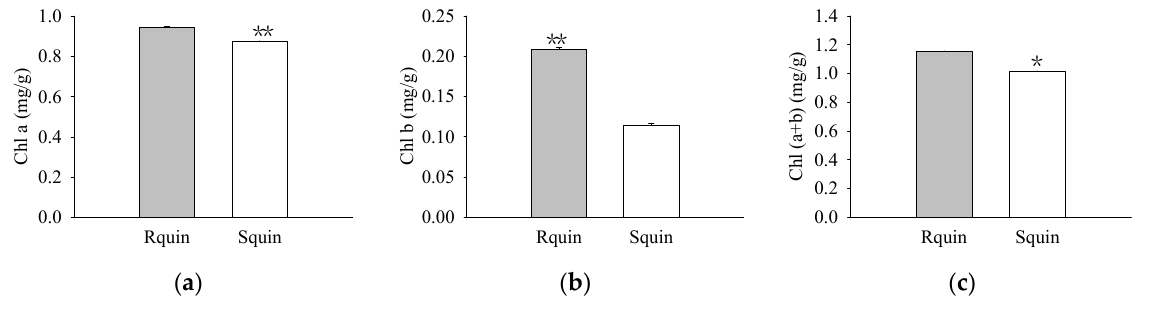
Figure 3. The chlorophyll (Chl) content of quinclorac-resistant (Rquin) and -sensitive (Squin) E. crusgalli with quinclorac treatment. ( a ) Chl a content; (b) Chl b content; (c) Chl (a+b) content. * represents a statistically significant difference ( p < 0.05), and ** represents a statistically significant difference ( p < 0.01).